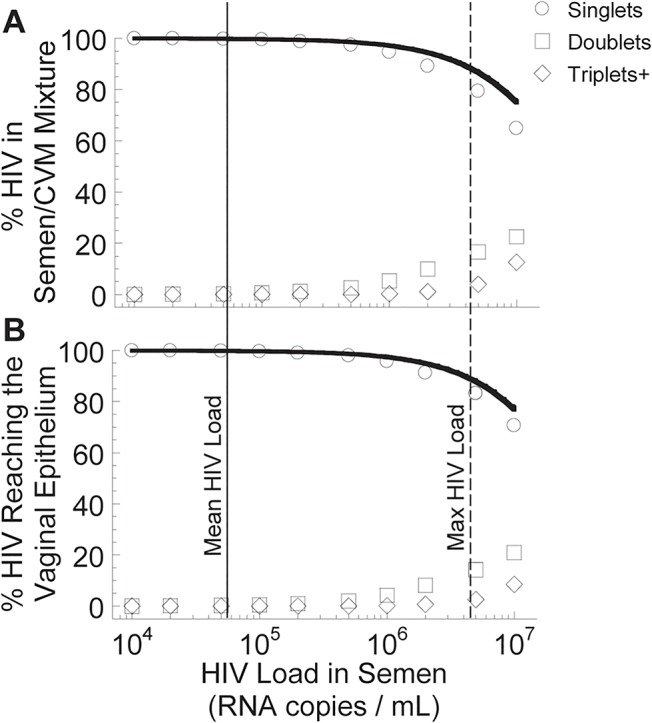
Maximum HIV collision rates for peak HIV concentration.The fraction of HIV virions in ejaculate that have undergone at least one, two, as well as three or more collisions over the first 12 hours post ejaculation as a function of HIV virion density in semen for (A) all HIV virions in the female reproductive tract, and (B) HIV virions that have diffused across CVM and reached the vaginal epithelium. Mean and maximum HIV viral load in semen is obtained from [16]. To enable rapid estimation of the viral load that may result in significant rates of agglutination, we also derived a mathematical equation (dashed curve; first summand of Eq 10) and utilized an exponential approximation (solid curve; Eq 3) that directly estimate the virion load arriving at the epithelial layer that experiences no collisions with other virions (see Appendix and S1 File).